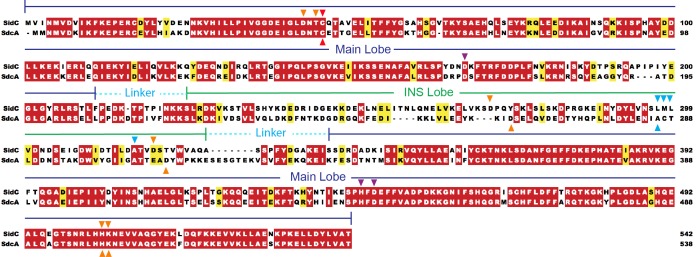
Sequence alignment of the SNL domain region of SidC and SdcA.The sequence alignment was calculated by Clustal Omega and colored by the Multiple Align Show online server. The INS and main lobes and the two linker peptides between the two lobes are labeled on the top of the sequences. Residues in either SidC or SdcA selected for mutagenesis and used in the enzymatic assays are labeled with red (catalytic residue), blue (at the E2 interface), gold (involved in Ub binding), or purple (forms the acidic patch near the catalytic site) triangles. Entrez database accession numbers are as follows: SidC, GI: 40792743; SdcA, GI: 52629829.